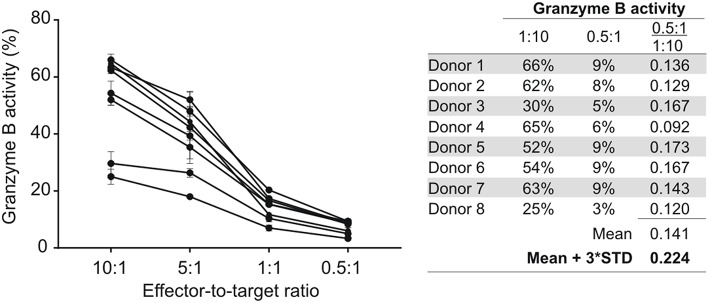
NK cell-mediated ADCC responses at different effector-to-target (E:T) cell ratios. NK cells isolated from eight HIV-1 negative donors were tested at different E:T ratios in an HIV-specific GranToxiLux assay using an ADCC-mediating monoclonal antibody (A32) at 2.5 μg/ml. The mean fraction of Granzyme B activity observed at an E:T of 0.5:1 relative to 10:1 was used to calculate a 99% confidence level cut-off value for NK cell-mediated ADCC responses at an E:T of 0.5:1. Data points represent the mean of triplicate measures and the standard deviation indicated by error bars.